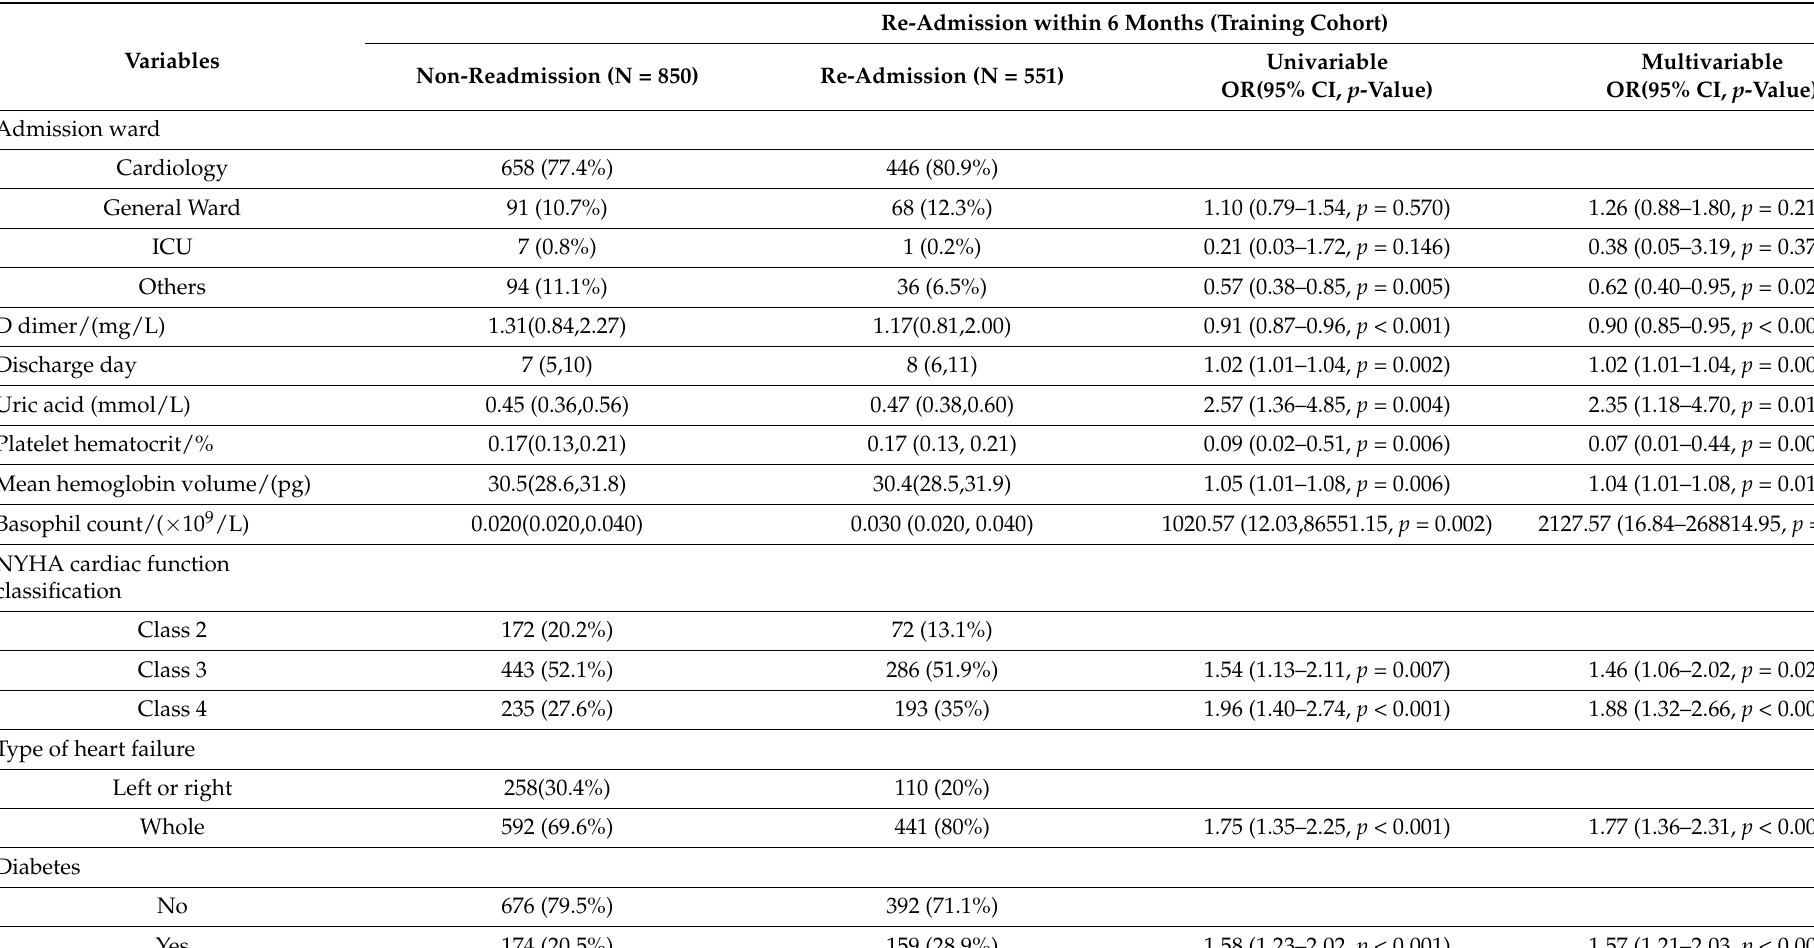
Table 2. Univariate and multivariable logistic regression analyses for six-month heart failure